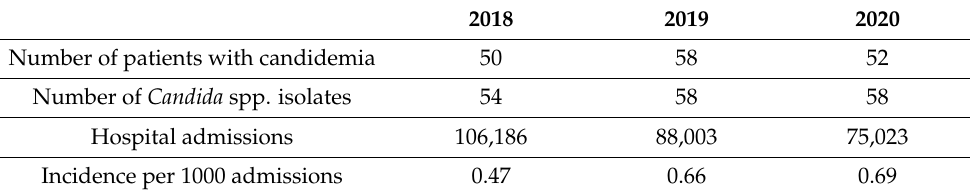
Table 1. Number of patients with candidemia, Candida spp. isolates, hospital admissions and incidence rates in three-year study period (2018–2020) .